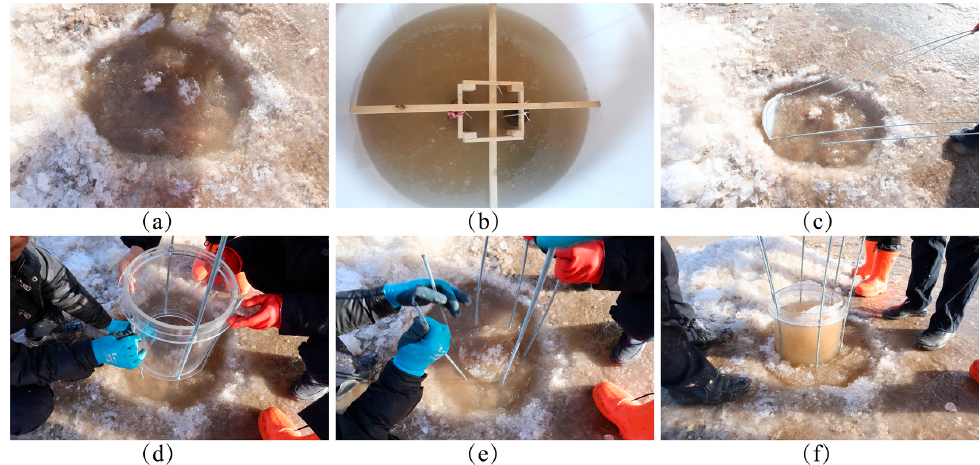
Figure 2. Process of frazil particle collection in the field: ( a ) drilling the hole in the ice; ( b ) fixing the wooden brackets and collecting the Yellow River water; ( c ) placement of the frazil particle sampler; ( d ) plexiglass tube insertion; ( e ) adjusting the ice sampler; ( f ) retrieval of the frazil particles.